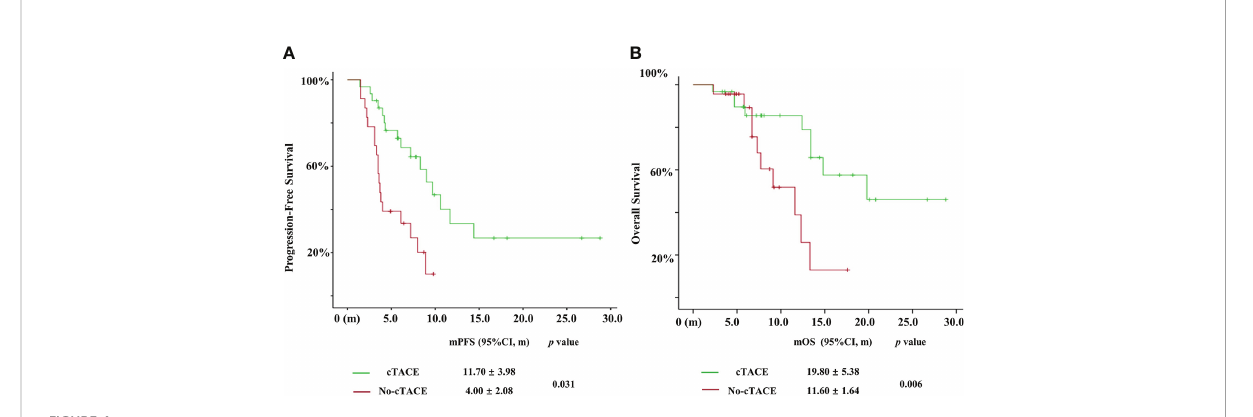
FIGURE 4 Kaplan-Meier analysis of PFS (A) and OS (B) in both groups.